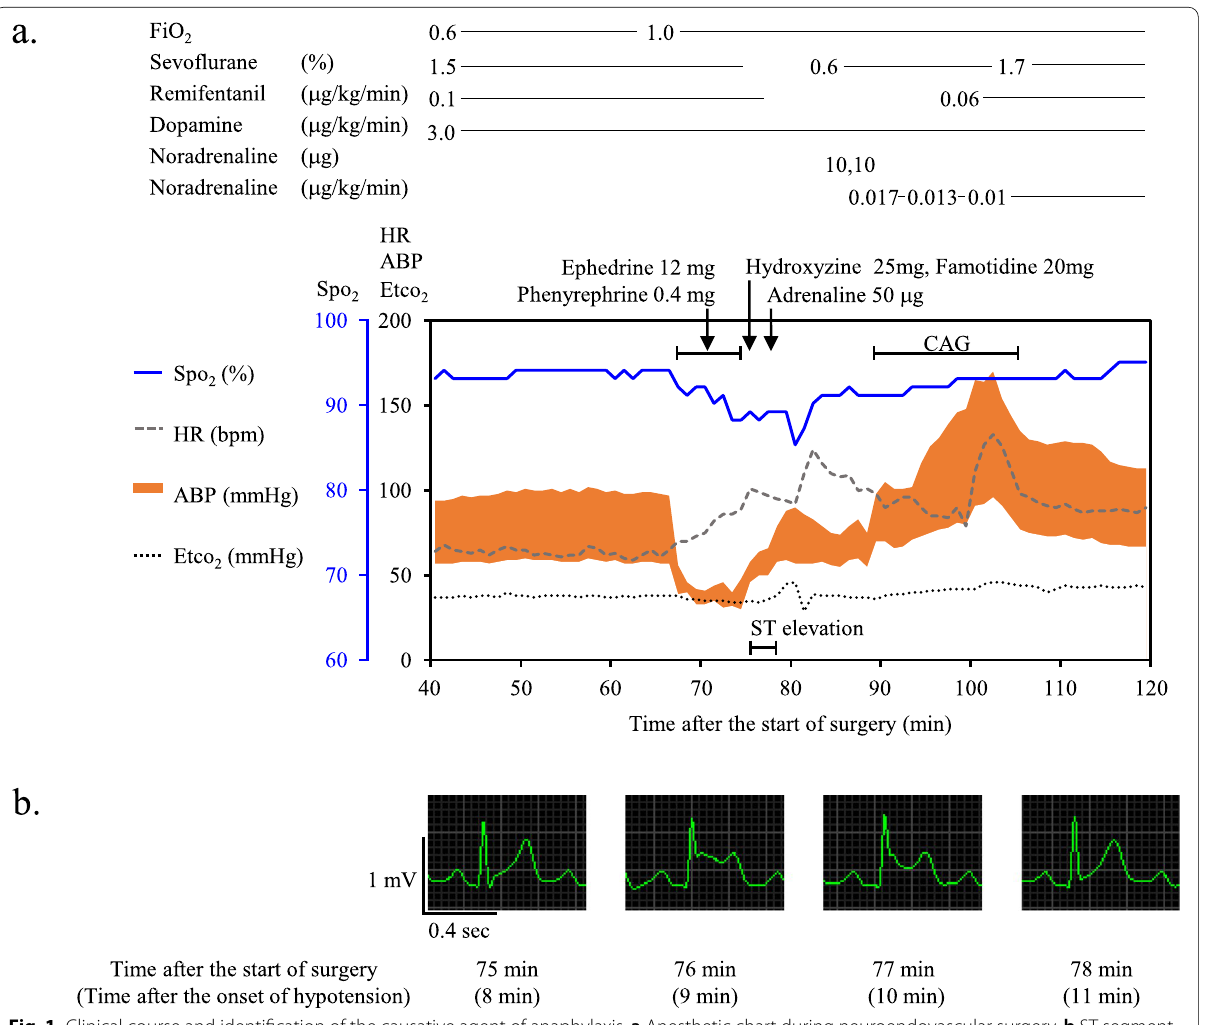
Fig. 1 Clinical course and identification of the causative agent of anaphylaxis. a Anesthetic chart during neuroendovascular surgery. b ST segment elevation after onset of hypotension. FiO 2 fraction of inspiratory oxygen, SpO 2 percutaneous oxygen saturation, HR heart rate, bpm beats per minute, ABP arterial blood pressure, EtcO 2 endo‑tidal carbon dioxide, CAG coronary